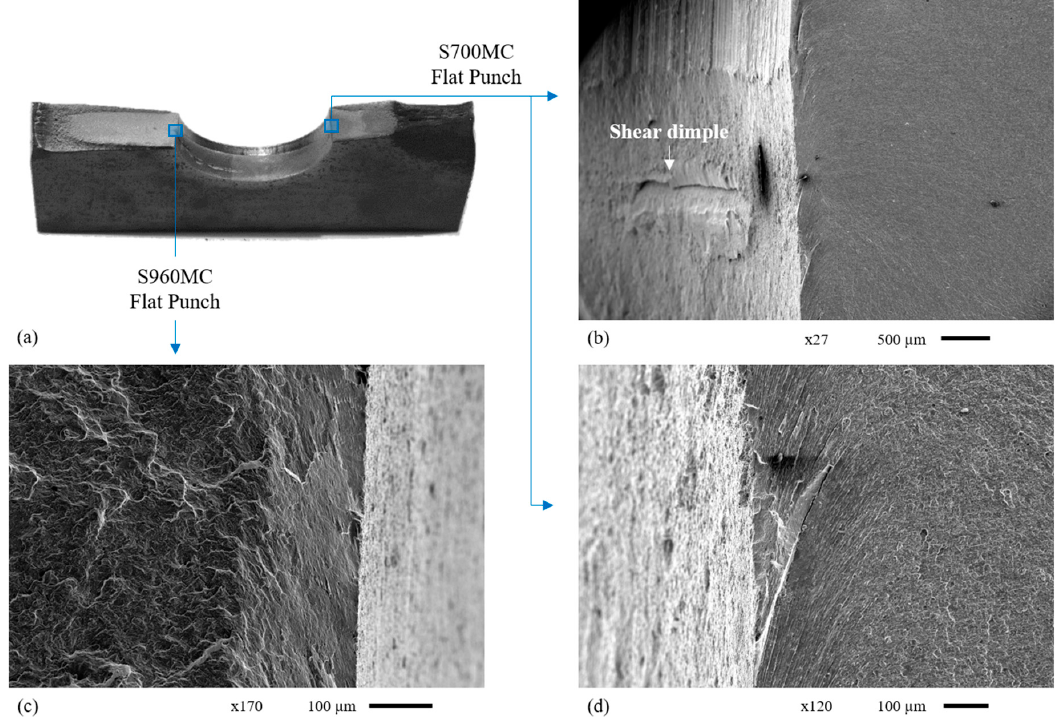
Figure 18. ( a ) Overview of fractured punched specimen. Fracture surfaces of flat-punched specimens: ( b )( d ) S700MC and ( c ) S960MC.